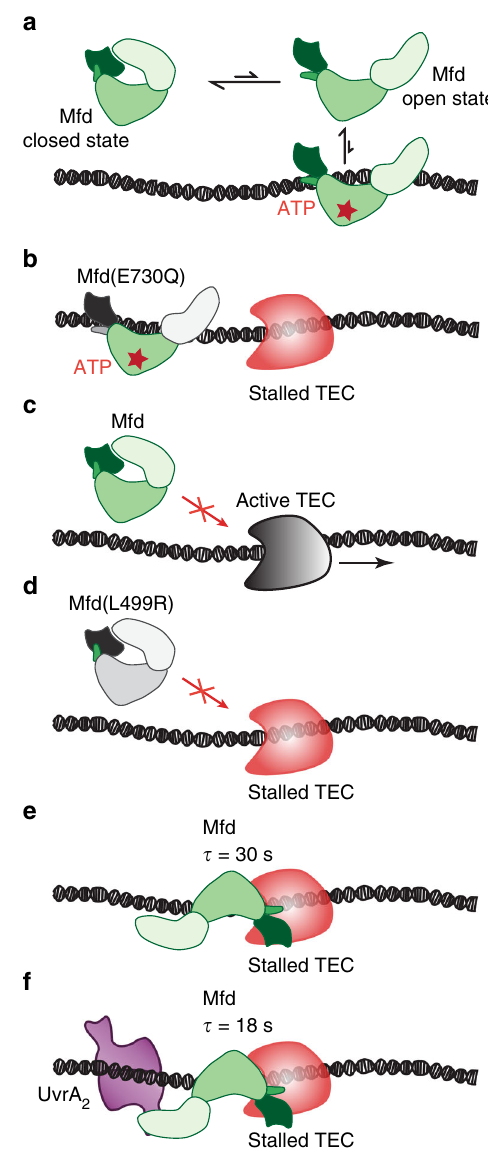
Fig. 6 Multi-layered regulation of Mfd activities in vivo. a In solution, Mfd exists in a dynamic equilibrium between the closed state and the ATP- bound open state that is capable of short-lived DNA binding. b An Mfd mutant (E730Q) that is de fi cient in ATP hydrolysis exhibits non-speci fi c DNA binding. c Active TECs are not a target for Mfd activity. Black arrow indicates the direction of TEC movement. d Stable association of Mfd and TEC is trigged by stalled TECs and involves the RNAP-interacting domain of Mfd. An Mfd mutant in which the RNAP-interacting domain is disrupted (L499R) loses the ability to engage stalled TECs. e Binding of Mfd is stimulated by stalled TECs, resulting in the formation of a long-lived complex with a lifetime of 30 s in the absence of UvrA. f UvrA 2 promotes the dissociation of Mfd from DNA, such that repair intermediates exhibit